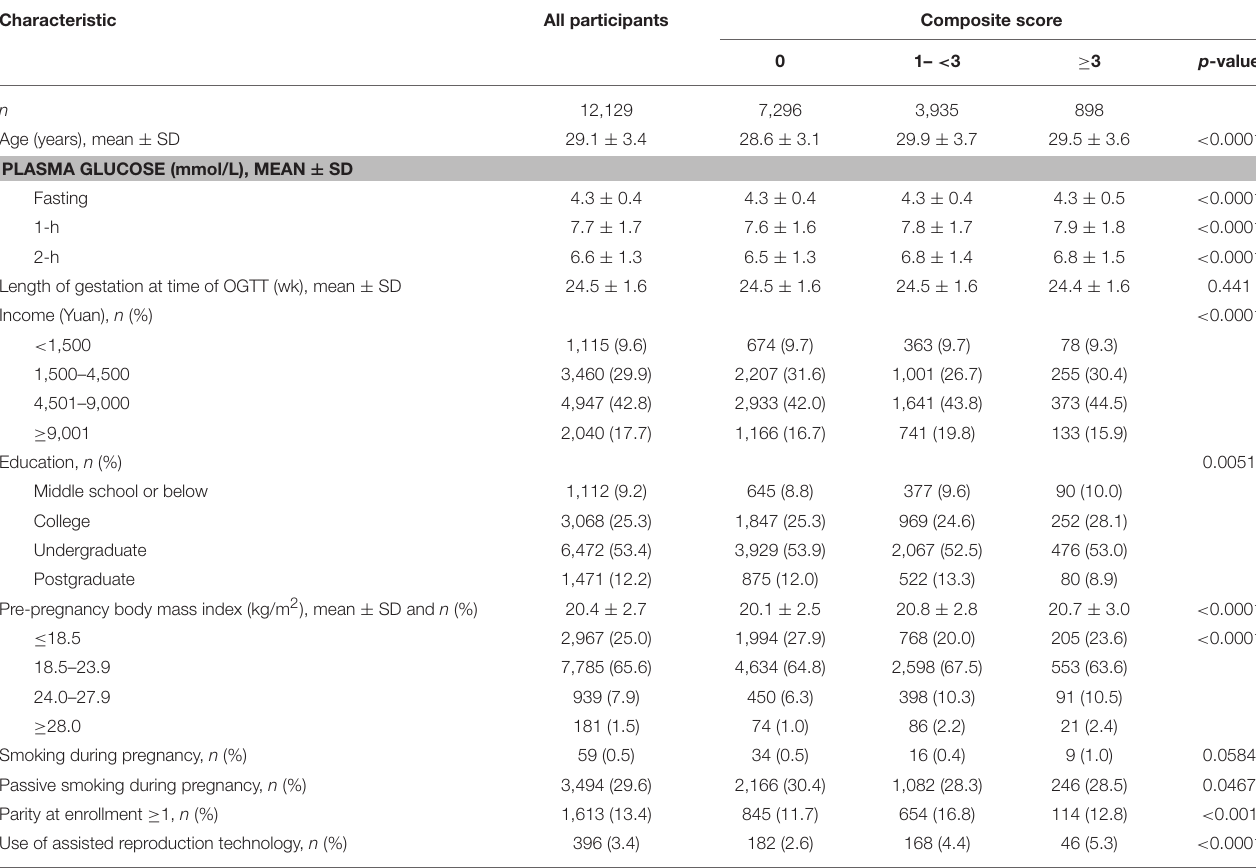
TABLE 2 | Characteristics of the 12,129 study participants and their newborns by different groups of composite score. Characteristic All participants Composite